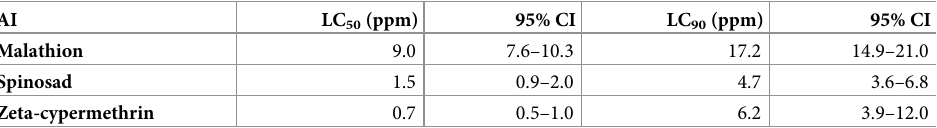
Table 1. LC 50 and LC 90 values for susceptible D . suzukii larvae exposed to three commonly used